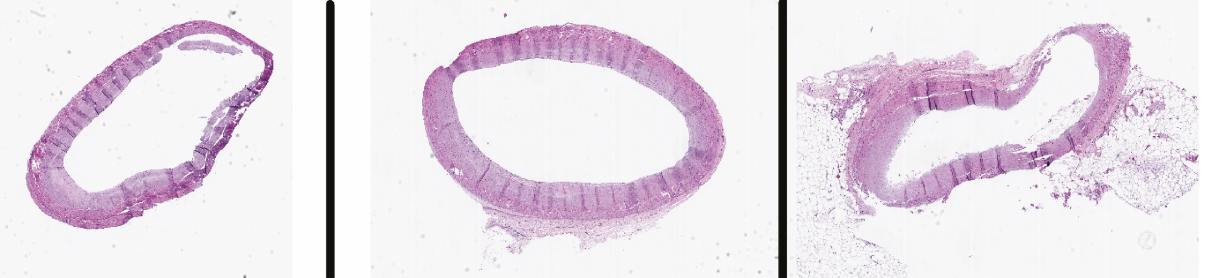
Figure 5: Cut sections of coronary arteries showing patent arteries with minimal